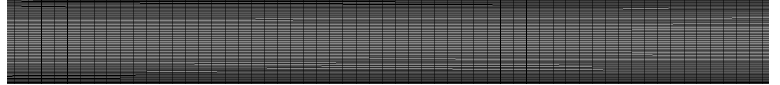
Figure 7. A 2D Cartesian structured mesh of 100 × 88 points (Yao et al. [44]).